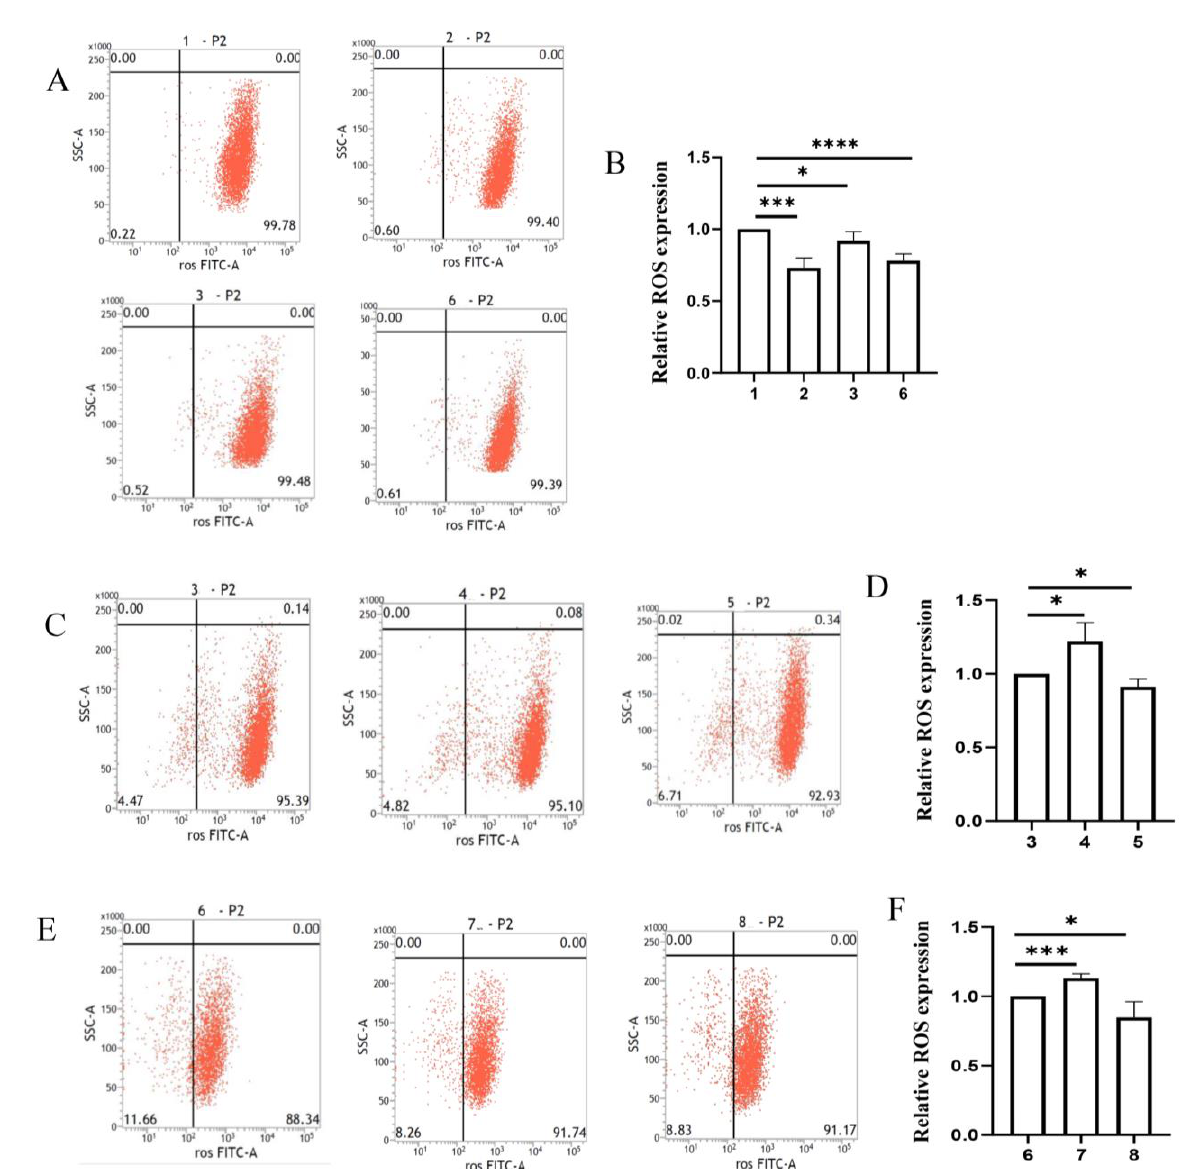
Figure 5. α -synuclein reduced the ROS content in neuron–microglia co-culture system by modulating IL6ST-AS/STAT3/HIF-1 α axis. SH-SY5Y cells were divided into eight groups: 1. only SH-SY5H cells, 2. α -synuclein-induced (25 µ mol/L) SH-SY5H cells, 3. SH-SY5H cells co-cultured with HMC3 cells, 4. SH-SY5H cells co-cultured with IL6ST-AS UP HMC3 cells, 5. SH-SY5H cells co-cultured with IL6ST-AS KO HMC3 cells, 6. SH-SY5H cells co-cultured with α -synuclein-induced (25 µ mol/L) HMC3 cells. 7. SH-SY5H cells co-cultured with α -synuclein-induced (25 µ mol/L) IL6ST-AS UP HMC3 cells, and 8. SH-SY5H cells co-cultured with α -synuclein-induced (25 µ mol/L) IL6ST-AS KO HMC3 cells. ( A , C , E ) Flow cytometric analysis of ROS levels in different SH-SY5Y cells. ( B , D , F ) Quantitative data of ROS fluorescence intensities in different SH-SY5Y cells. Data = mean ± SD, * indicates p < 0.05, *** indicates p < 0.001, **** indicates p < 0.0001.